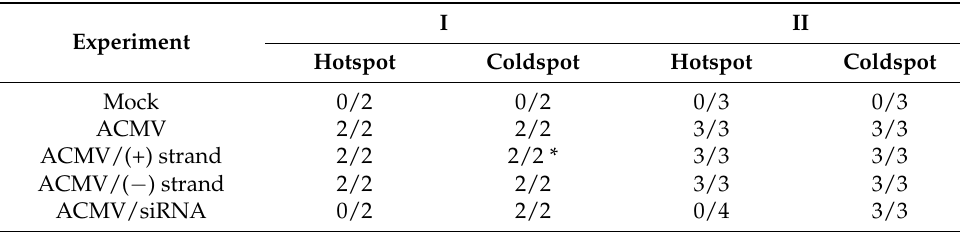
Table 2. Suppression of viral infection by hotspot